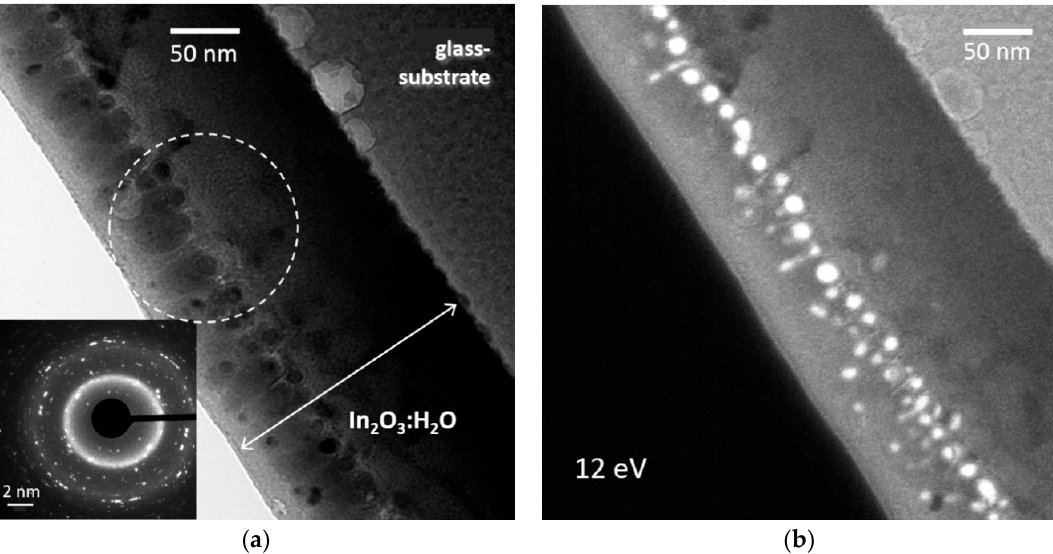
Figure 3. Medium magnification bright field image ( a ) and EFTEM image at an electron energy loss of 12 eV ( b ) obtained on an as-deposited In 2 O 3 :H 2 O film at the same location. Image ( a ) elucidates two parts of the film: the bottom ~100 nm thick amorphous part and the top ~50 nm thick crystalline part. The electron diffraction pattern is obtained for the region, marked by a circle. Bright regions in the figure ( b ) correspond to metallic indium.